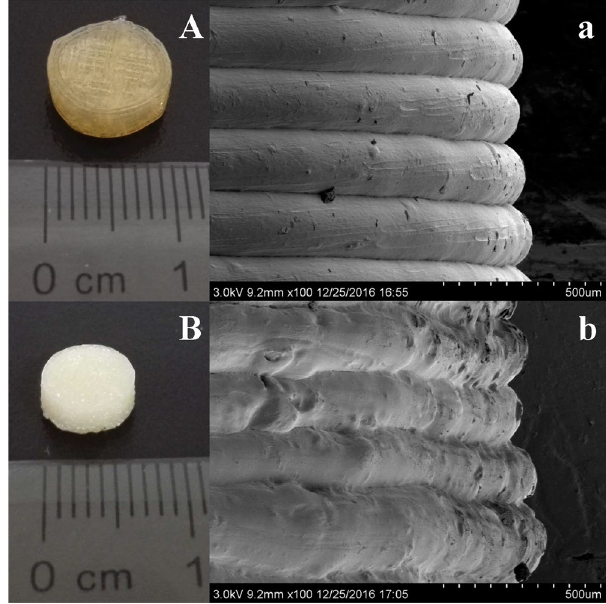
Figure 2. Images of 3D printed tablets: DOM-HPC tablet ( A ) and BaSO 4 -HPC tablet ( B ); SEM images of tablet side surfaces: DOM-HPC tablet (a) and BaSO 4 -HPC tablet